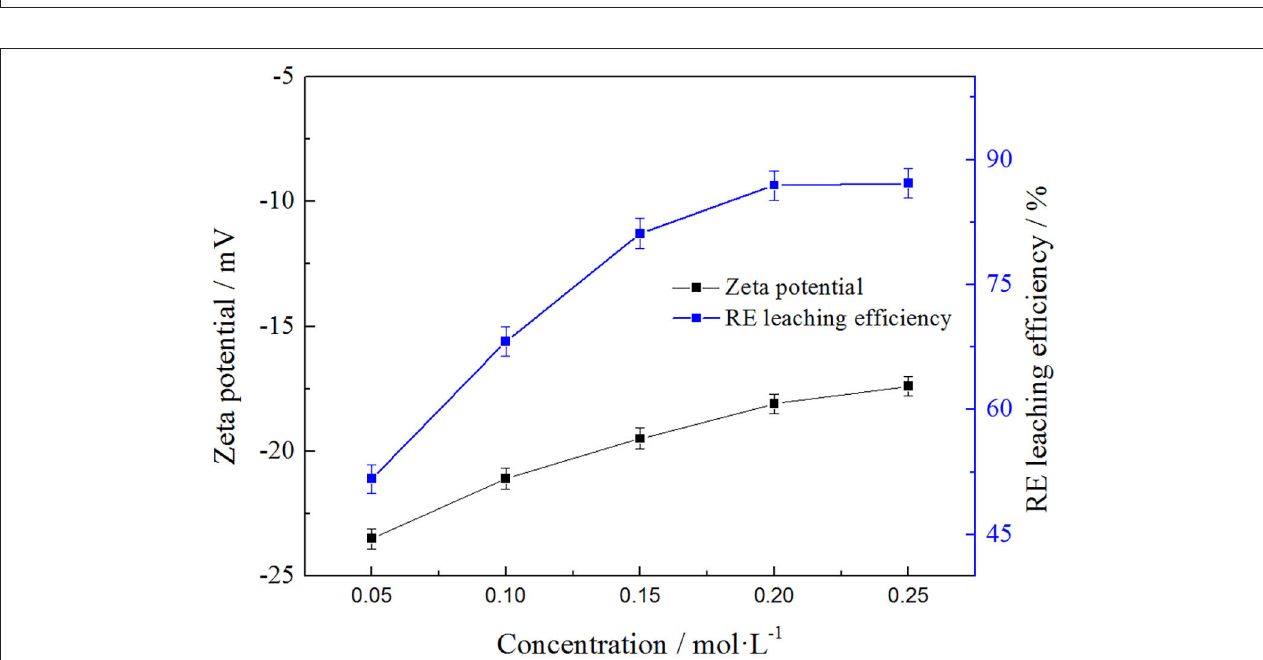
FIGURE 4 | Relationship between zeta potential and rare earth